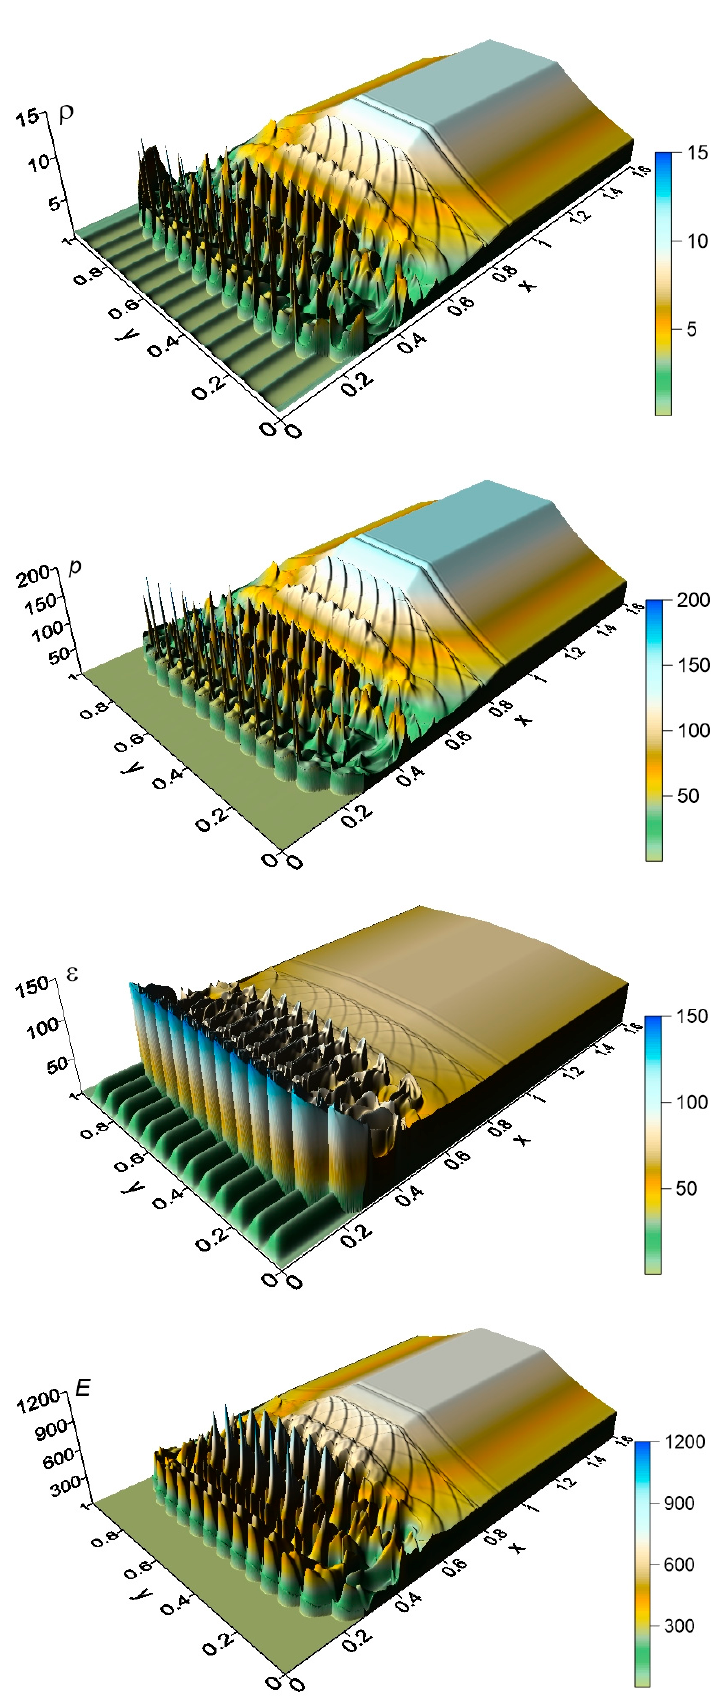
Figure 9. Fields of the considered parameters ( ρ , p , ε and E ): M = 12, α = 0.1, t = 0.08.